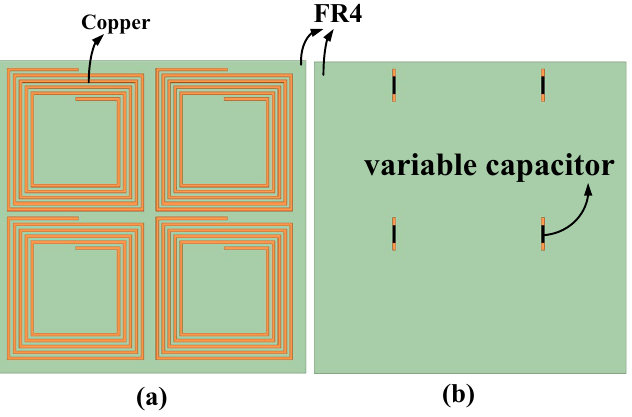
Figure 4. ( a ) Top and ( b ) bottom view of the frequency reconfigurable